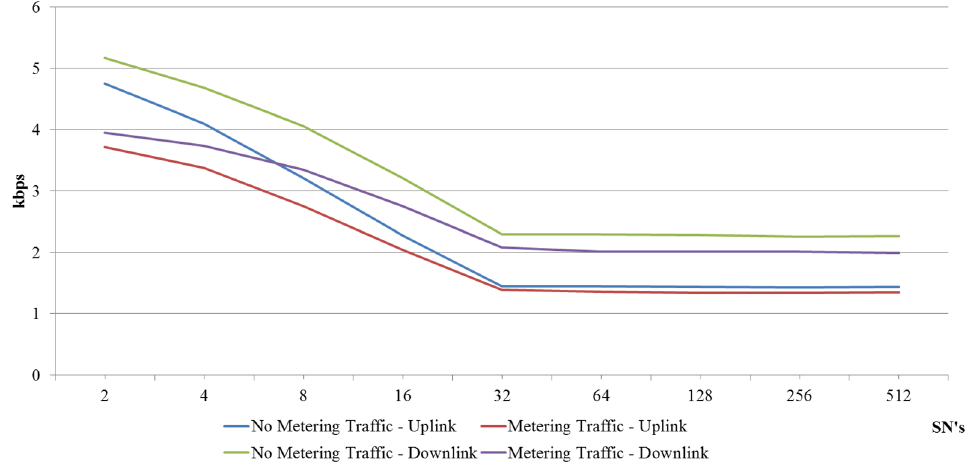
Figure 2. Data rate simulation based on ITU ‐ T G.9904.